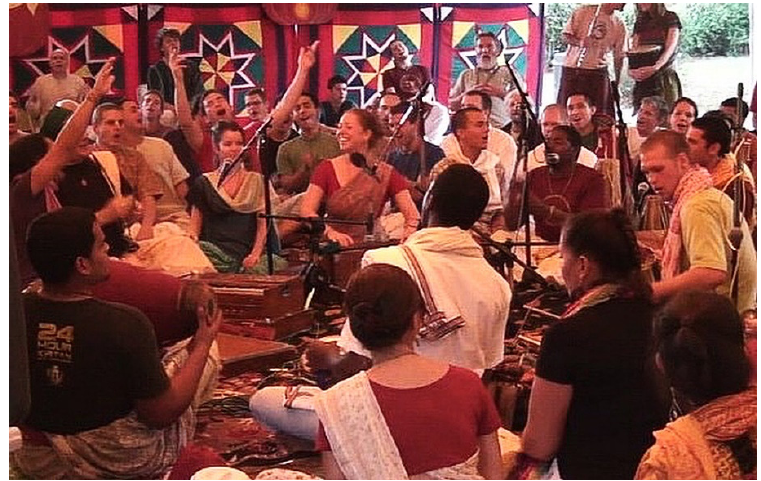
Figure 5. Kirtan at the Festival of the Holy Name, with Jahnavi seated at the